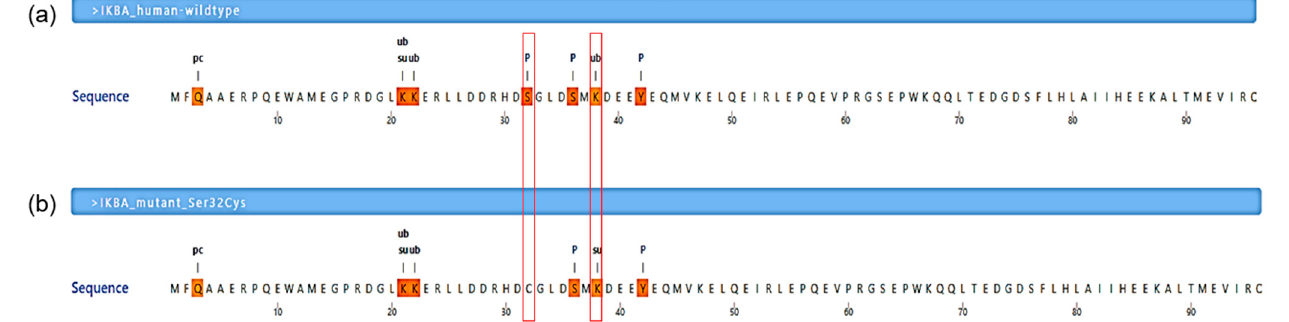
Figure 3. Post-translational modification prediction by a deep-learning algorithm. ( a ) A segment of human NF- κ B inhibitor α (I κ B α ) wild-type protein sequence (residues Met1-Cys96 are shown). ( b ) A segment of human I κ B α mutant protein (Ser32Cys) sequence (residues Met1-Cys96 are shown). The symbol pc denotes the pyrrolidone carboxylic acid site, ub denotes the ubiquitination site, su denotes the sumoylation site, and p denotes the phosphorylation site. The mutation was predicted to abolish the phosphorylation site at residue 32 and gain a sumoylation site at residue 38 (these two residues are indicated in the red line boxes).